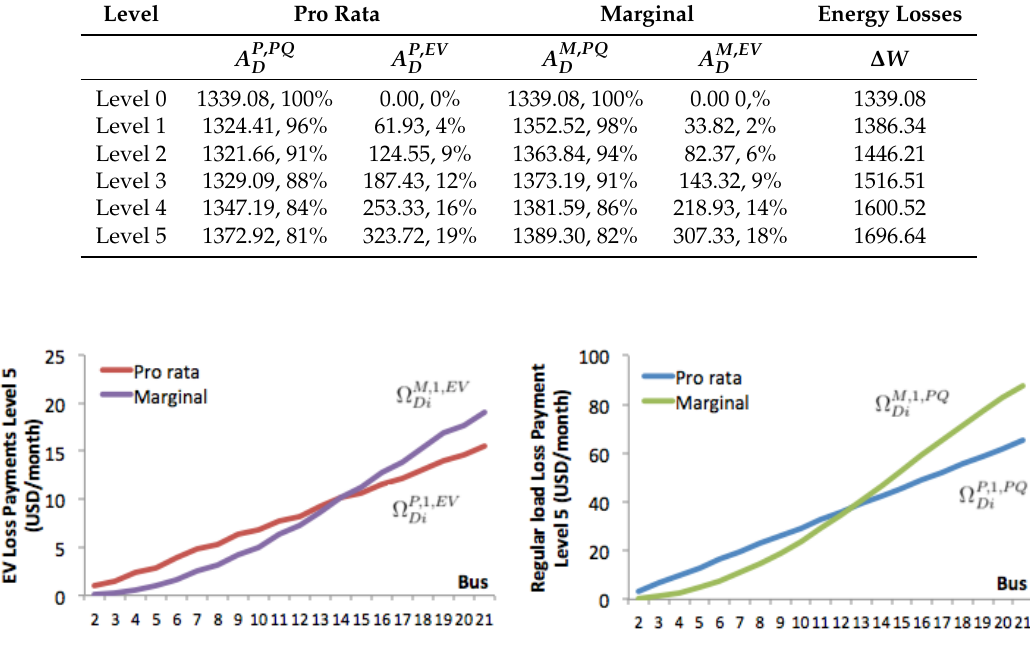
Figure 7. Off-peak load scenario: economic allocation between PQ and EV users connected at Phase 1 (Level 5).